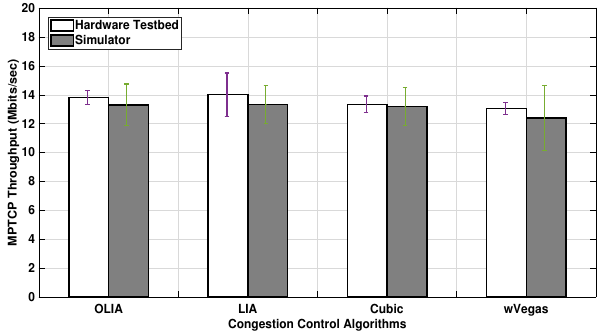
Figure 6. Setup 1 Uplink MPTCP Throughput for 75 MB